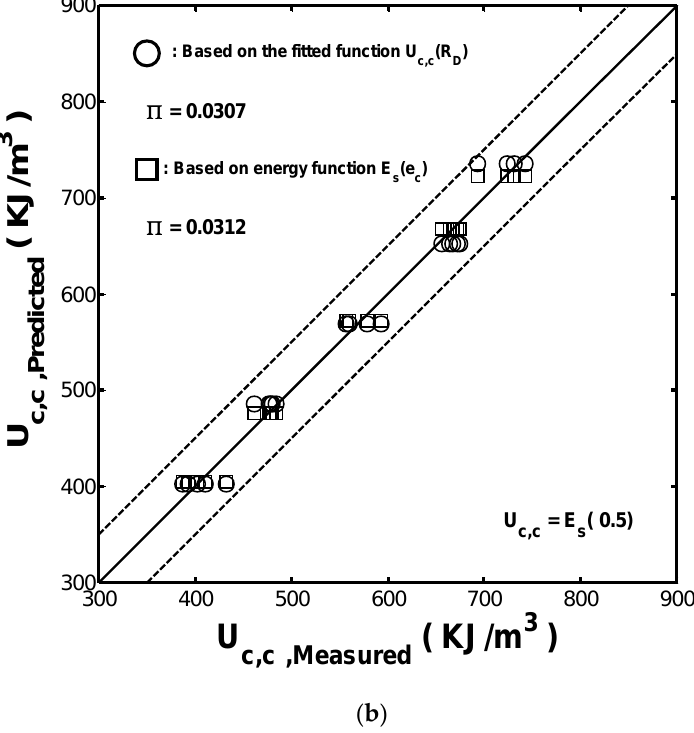
Figure 9. Comparison of the measured and predicted values of ( a ) strength and ( b ) toughness of the fenders with different wall thicknesses. Note that the predicted values of the compression strength and compression toughness are obtained from both the stress/energy polynomial functions and the fitted functions, 𝑆 𝑐,𝑐 (𝑅 𝐷 ) / 𝑈 𝑐,𝑐 (𝑅 𝐷 ) , for comparison purposes.